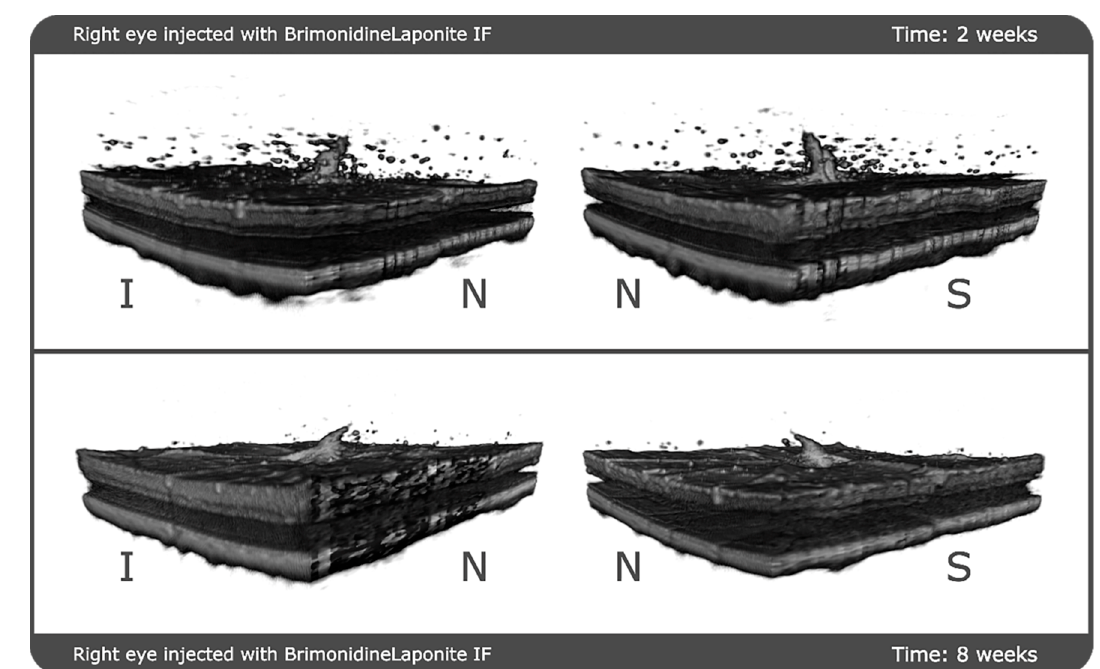
Figure 6. 3-D reconstruction of the evolution of the aggregates at 2 weeks and 8 weeks of follow-up. The reconstruction is shown from two different perspectives at each point in time. Abbreviations: N: nasal; I: inferior; S: superior; IF: intravitreal formulation.